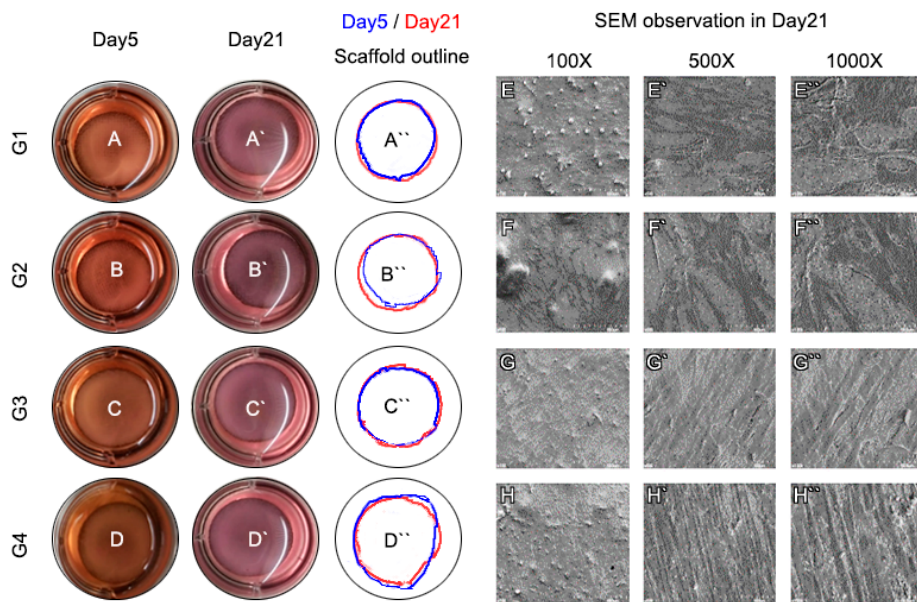
Figure 2. Sample observation. (A–D) The gelled bioink did not collapse but retained its original printed form in all groups till 21 d. (E–H) SEM showed that in the seeding groups (E,F), PDL cells had no directional alignment and were not well organized. However, in bioprinting groups (G,H), PDL cells were well aligned and had directional alignment.